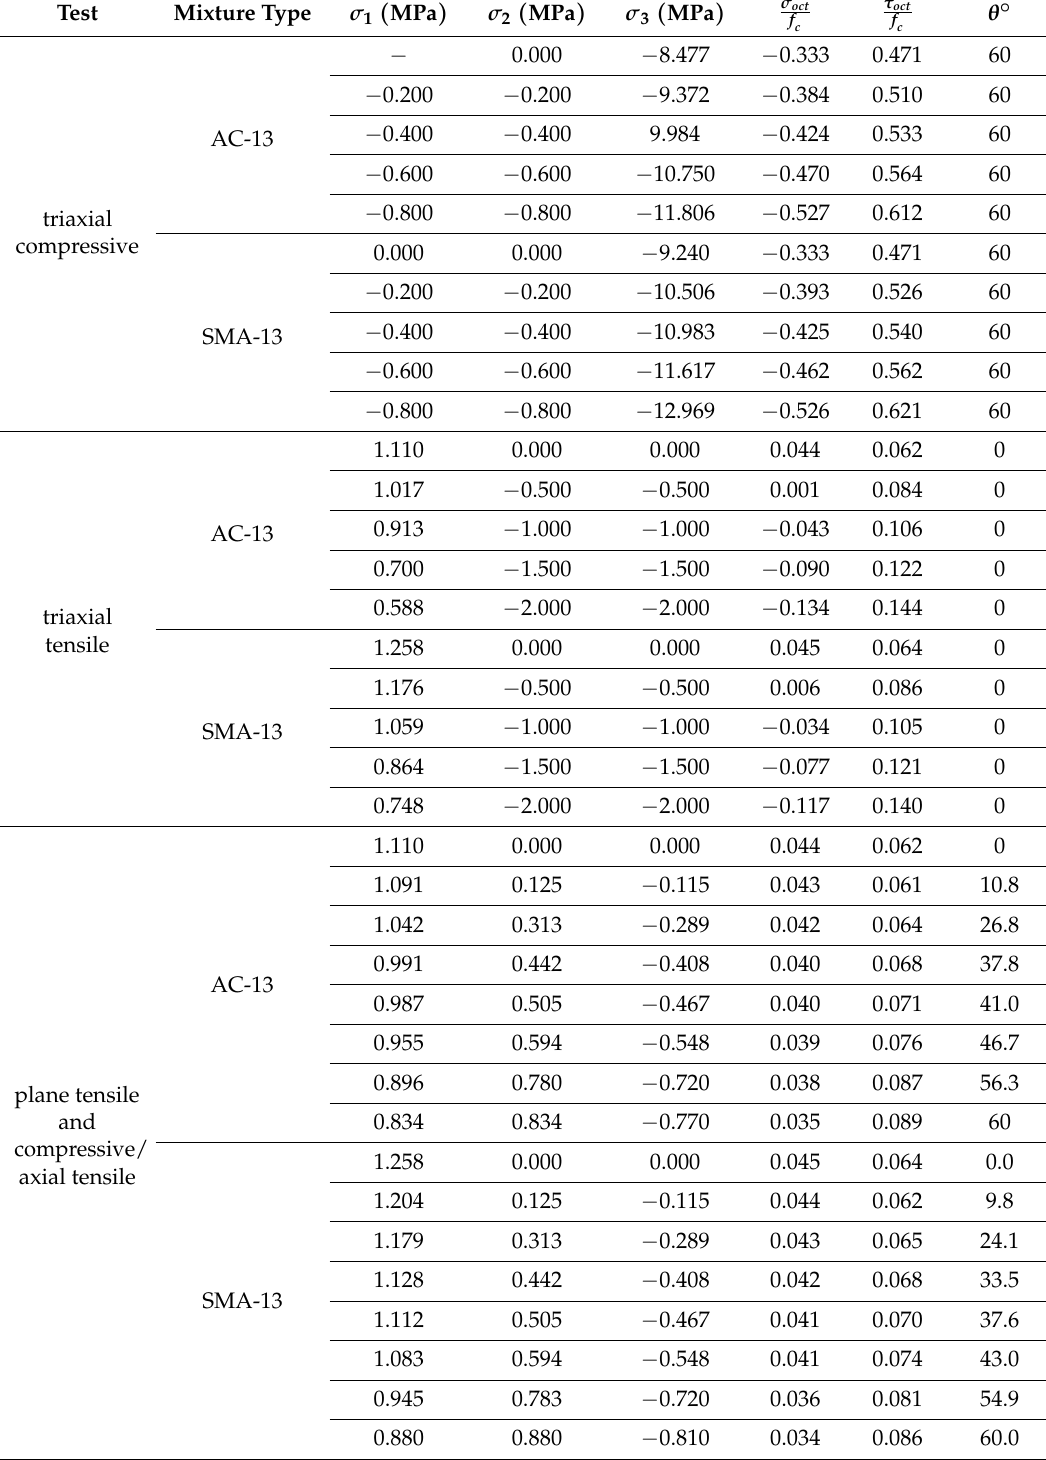
Table 3. Results of triaxial tests for asphalt